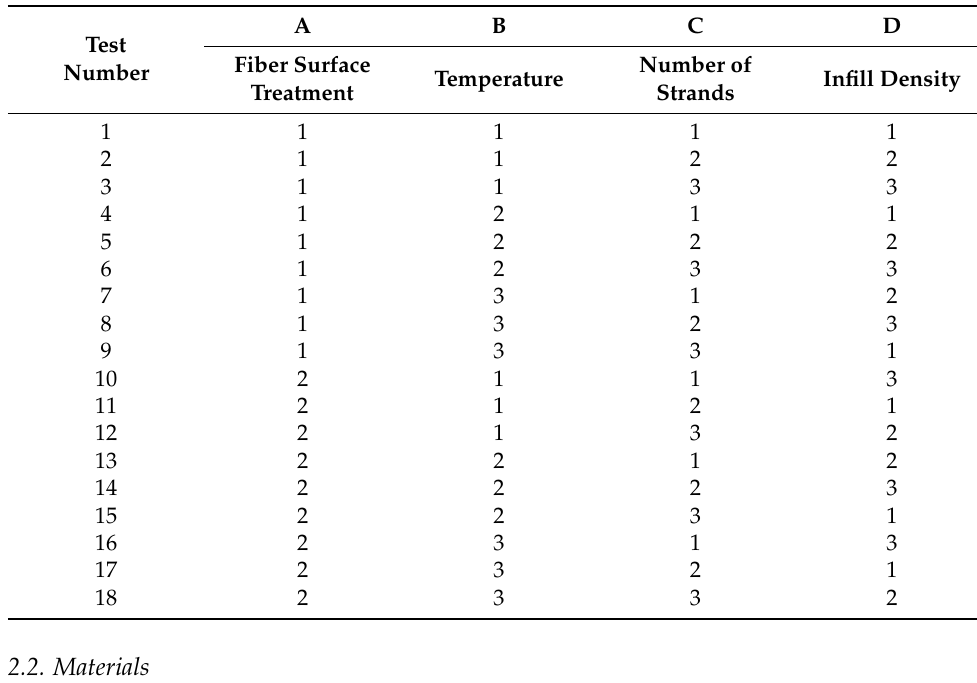
Table 2. Taguchi L18 orthogonal array.